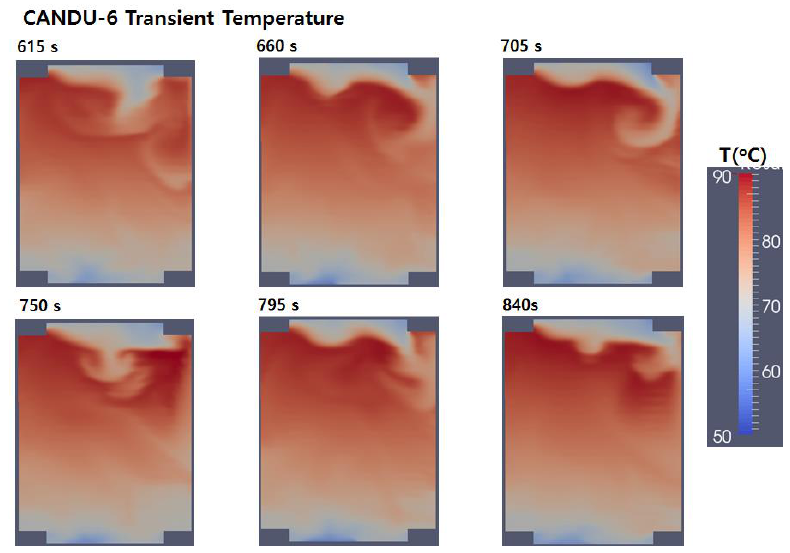
Figure 10. Temperature distribution at x = 0; 615 – 840 s.